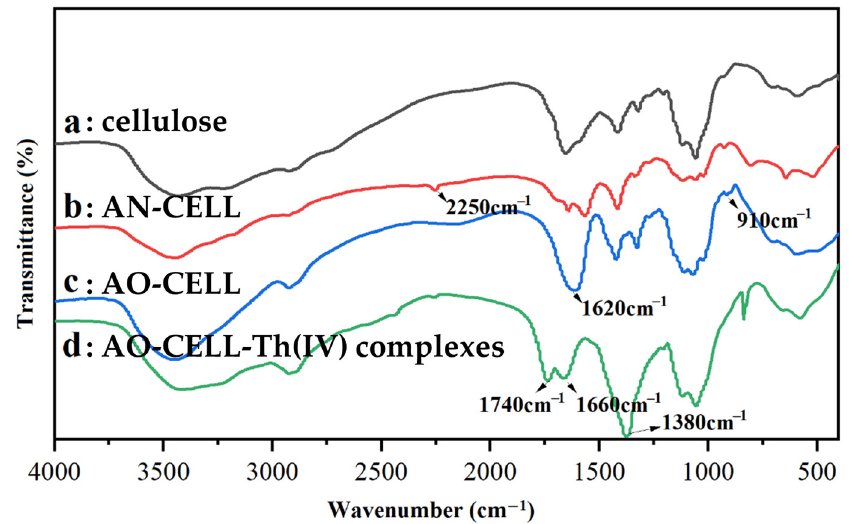
Figure 3. FT-IR spectra of cellulose and its derivatives.